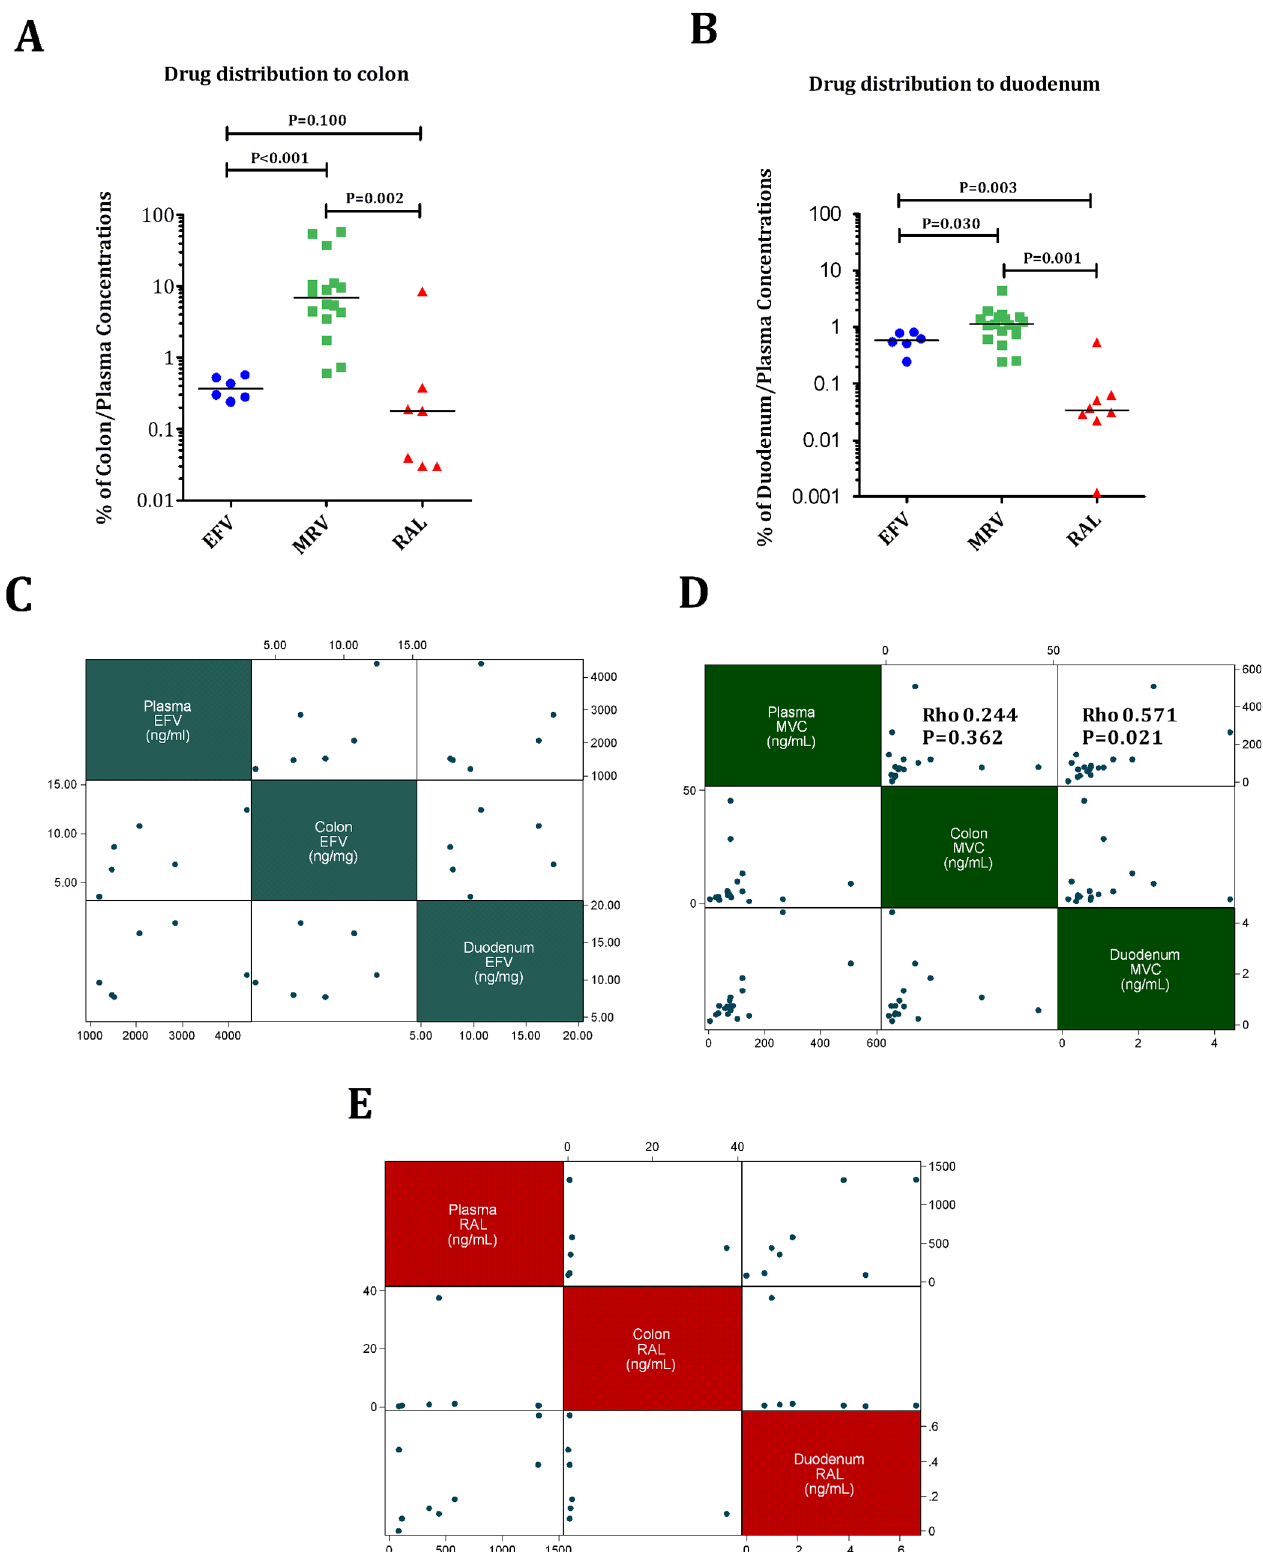
Fig 7. Tissue drug distribution. Panels A-B. Percentages of rectum/plasma (A) and duodenum/plasma (B) drug concentrations. Maraviroc reached the highest distribution to rectum and duodenum (all P < 0.005). Panel C-E. Correlations between plasma, rectum and duodenal levels of EFV (C), MVC (D) and RAL (E). MVC plasma levels correlated better with tissue levels than RAL or EFV. The Purple dash line represents cross-sectional mean values in